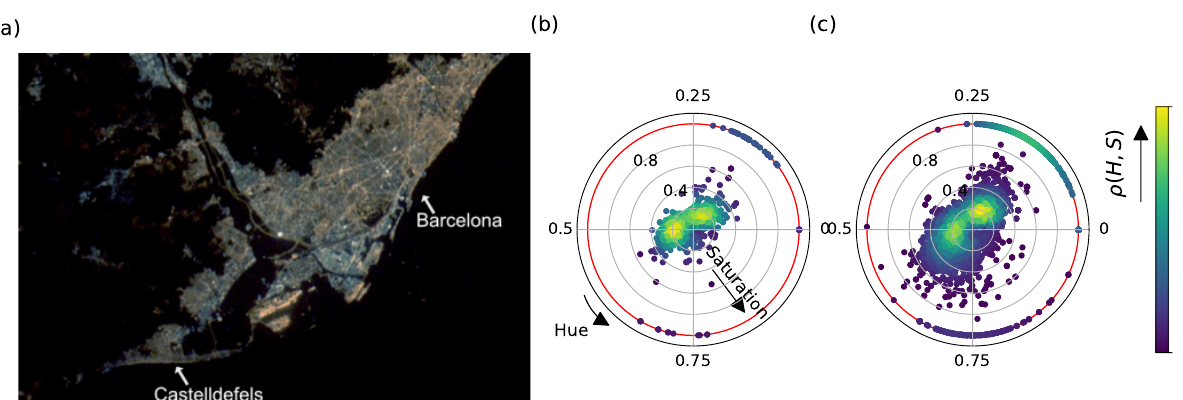
Figure 7. ( a ) Satellite image of the metropolitan area of Barcelona from the International Space Station. ( b ) H-S diagram of the colours of the pixels of picture ( a ) associated with the locations of NightUp photos. ( c ) H-S diagram of the colours of the pixels of picture ( a ) associated with the streetlights from the city council database. The colour of each point represents its kernel density estimation value with respect to a Gaussian kernel ρ ( H , S ) (see main text for details). The outer red rings in picture ( b , c ) correspond to the saturation value S =